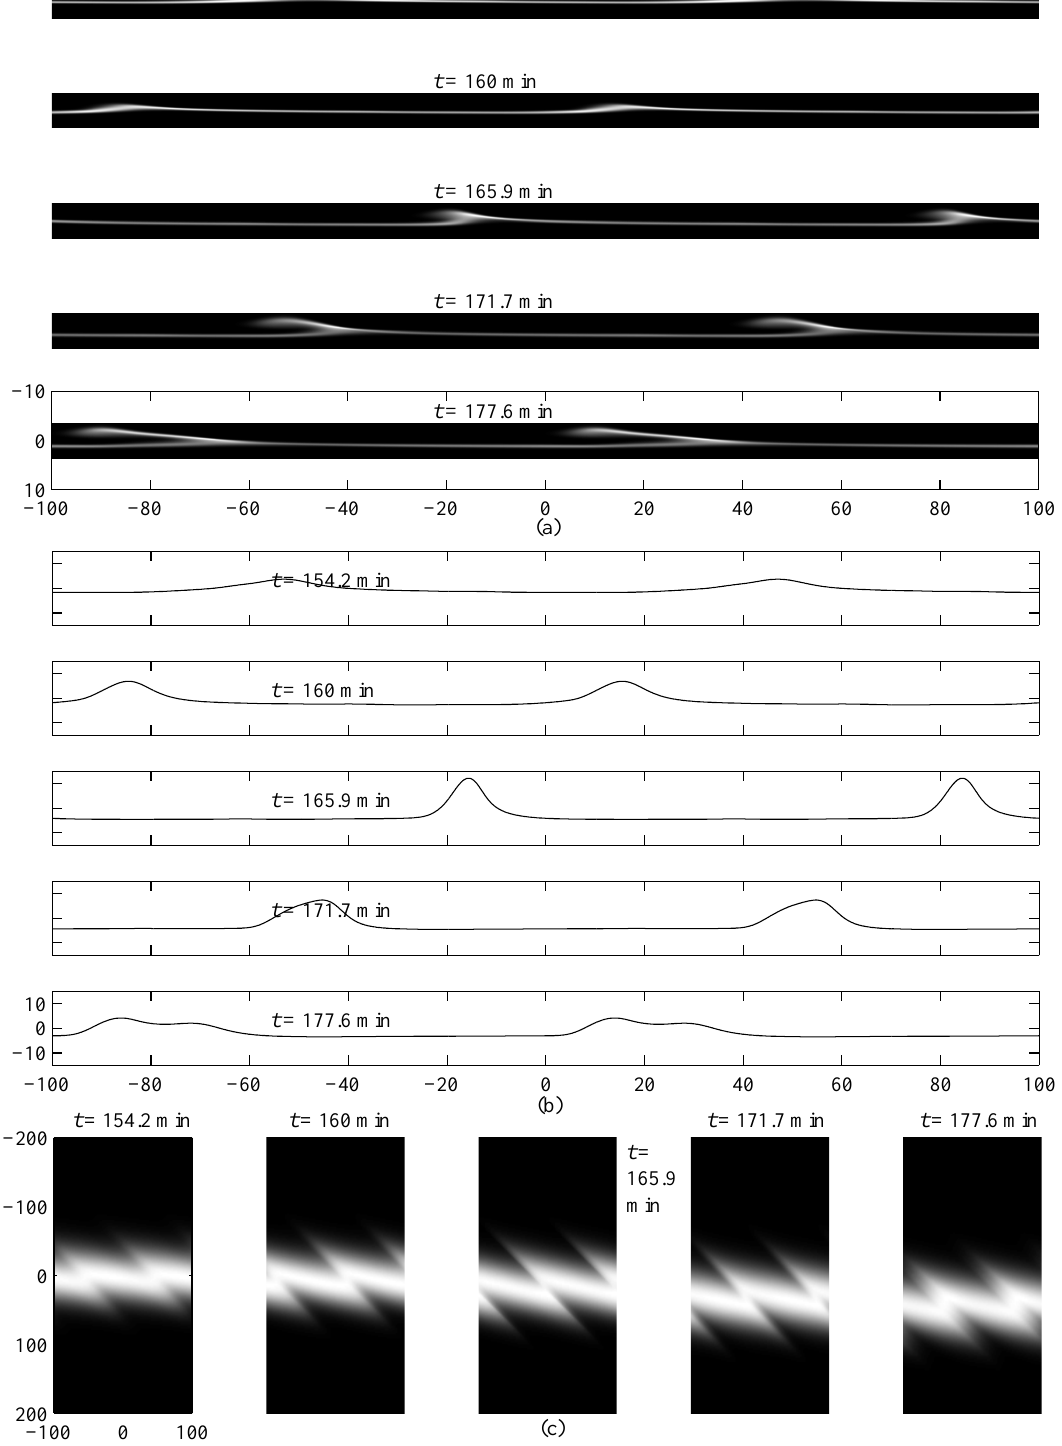
Figure 3: Seed wavelength of 100 km with Σ H Σ = 1 . 8. (a) E s layer, (b) electric field, and (c) F layer. The axes for all figures are described in Section 2.2, and summarized in Figure 1.